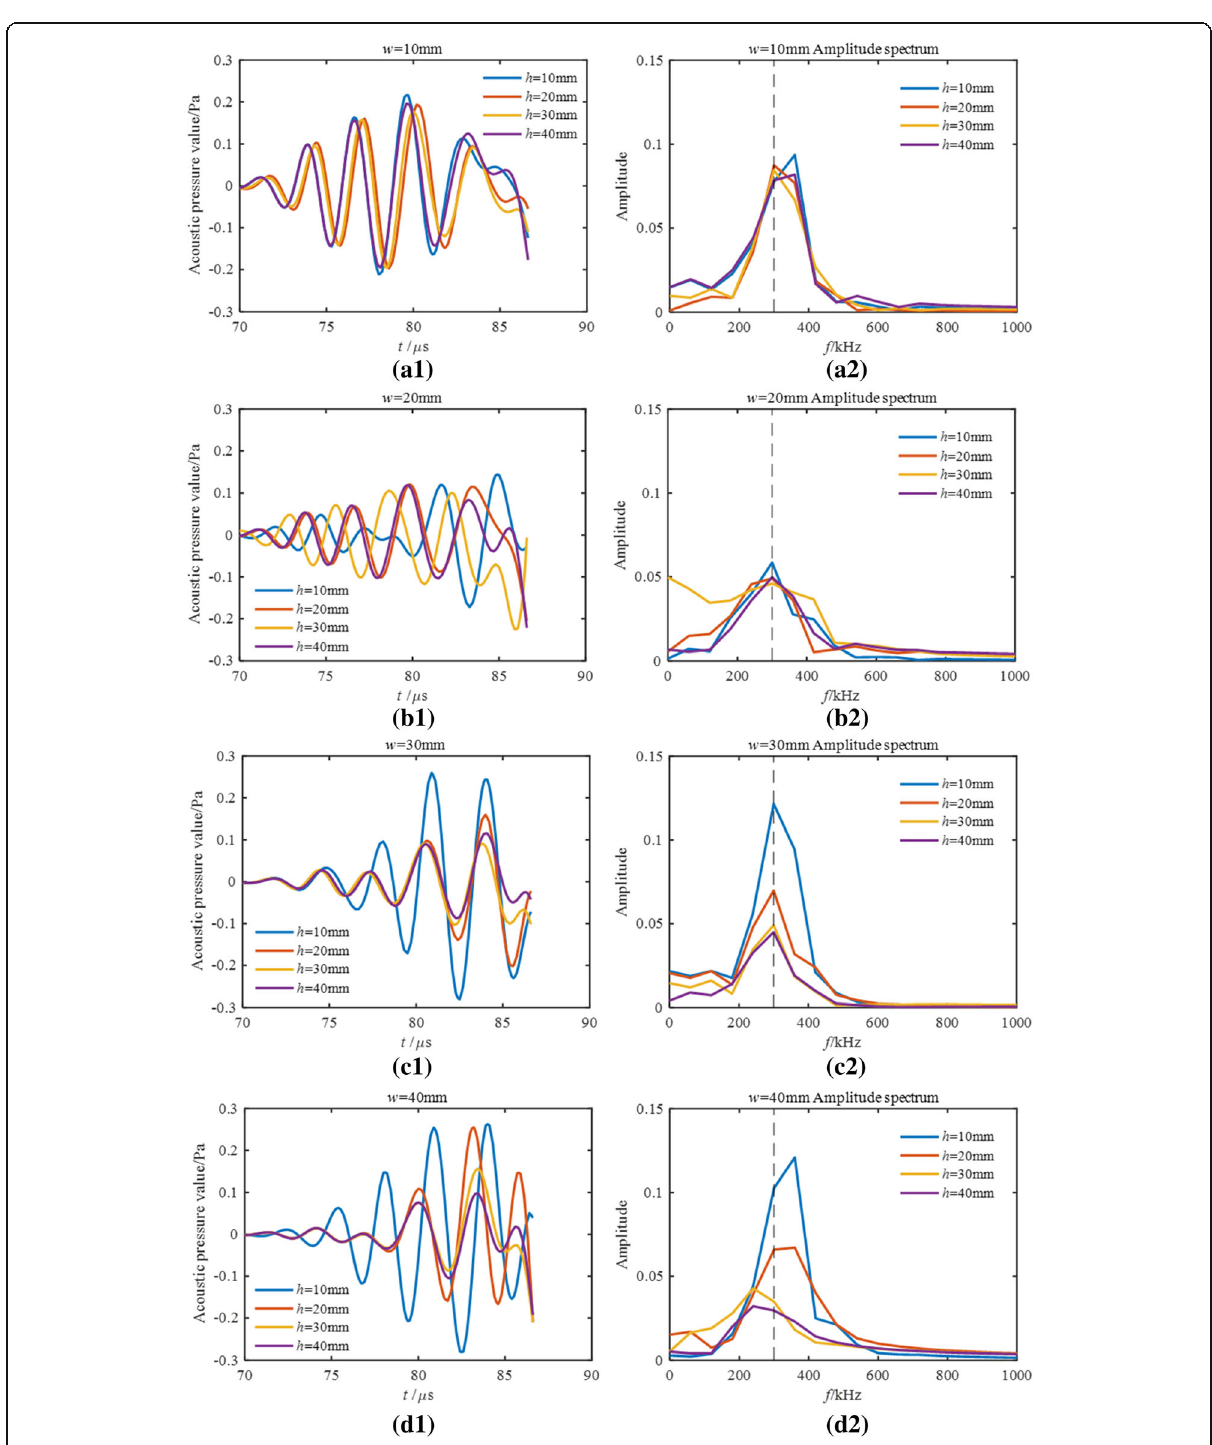
Fig. 7 The time domain and frequency domain signal of received direct waves with different w and h of shielding structures: a w = 10 mm (a1) time domain, (a2) frequency domain, b w = 20 mm (b1) time domain, (b2) frequency domain, c w = 30 mm (c1) time domain, (c2) frequency domain, and d w = 40 mm (d1) time domain, (d2) frequency